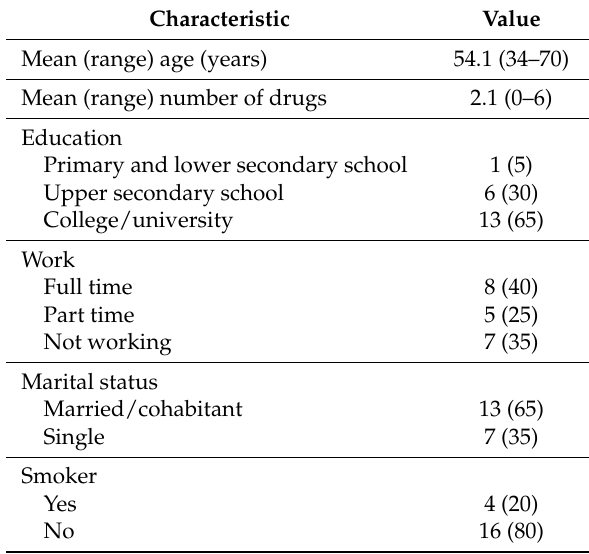
Table 1. Sociodemographic characteristics of the 20